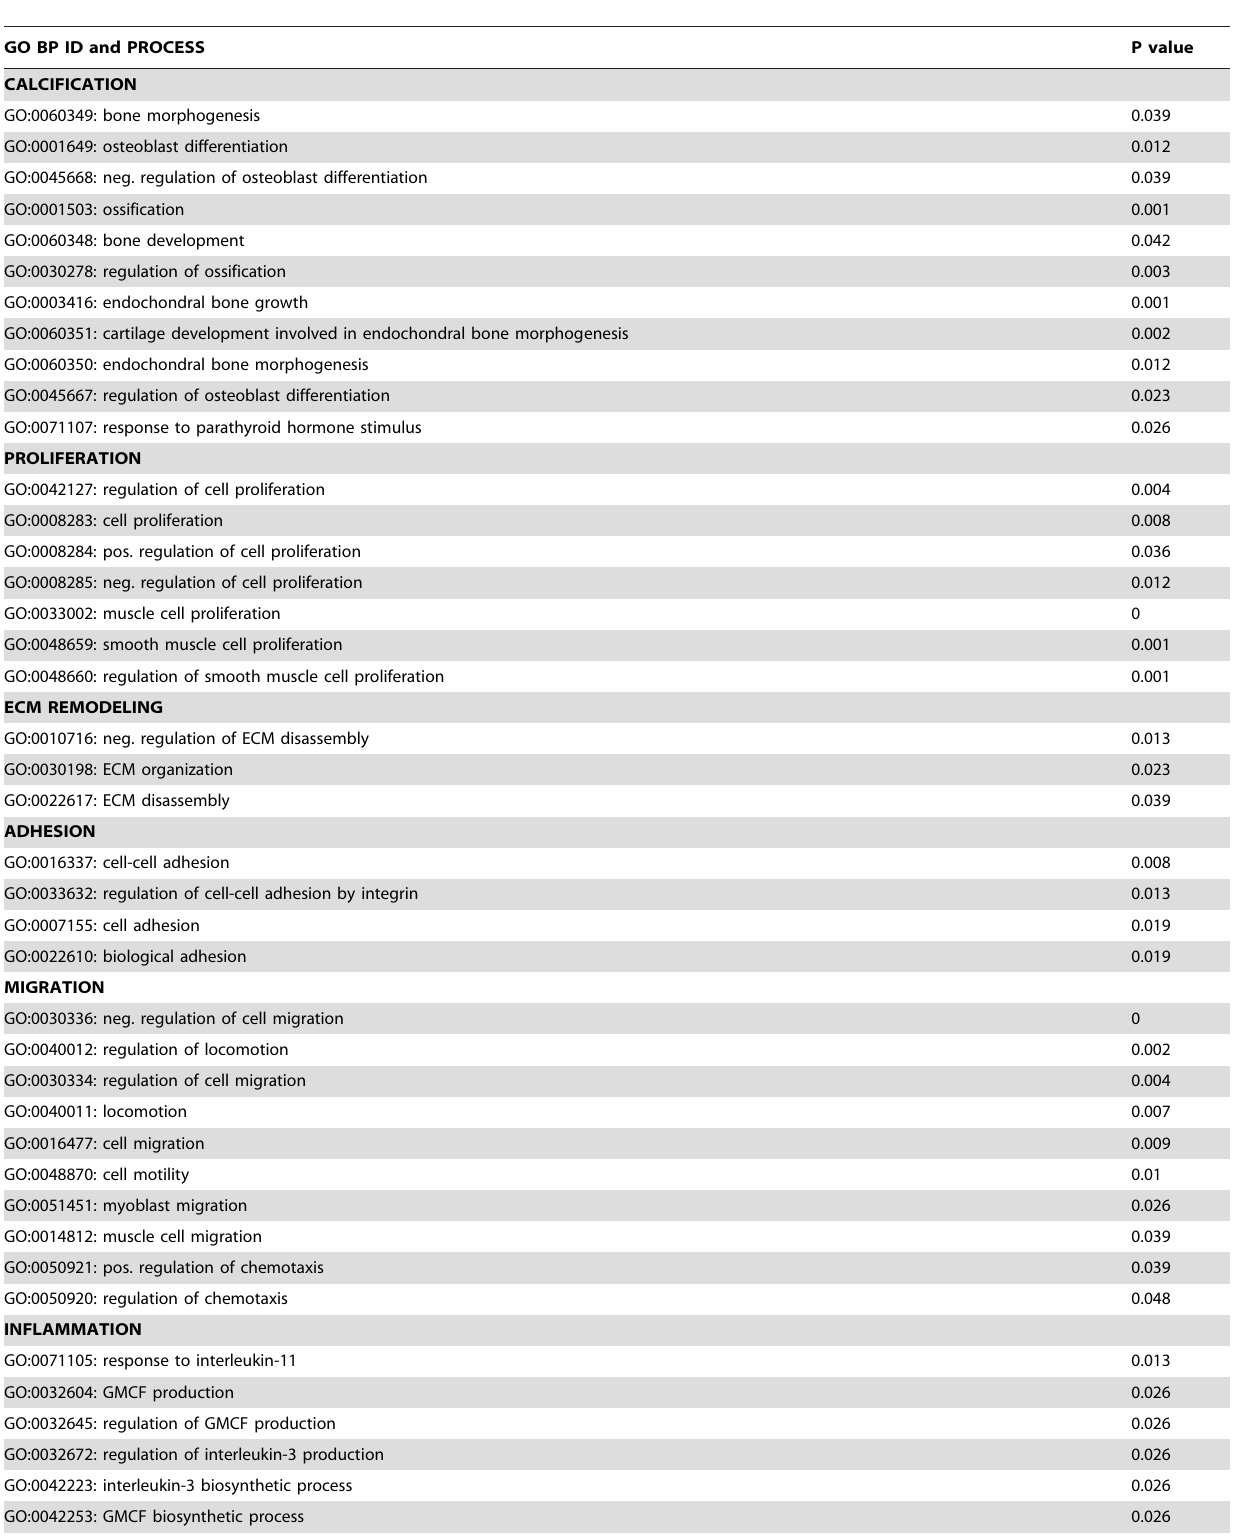
Table 1. Significant biological processes determined by GO enrichment analysis and categorized according to disease-related pathway grouping (expanded table available in Table